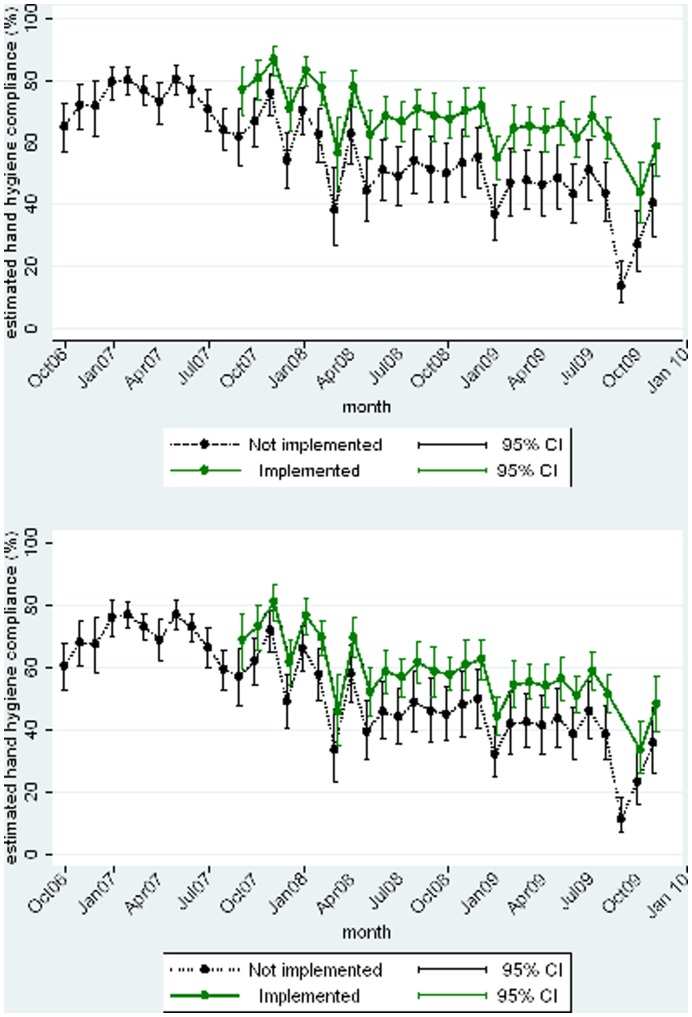
Hand-hygiene compliance in ITUs (upper panel) and ACE wards (lower panel): Per-protocol analysis.